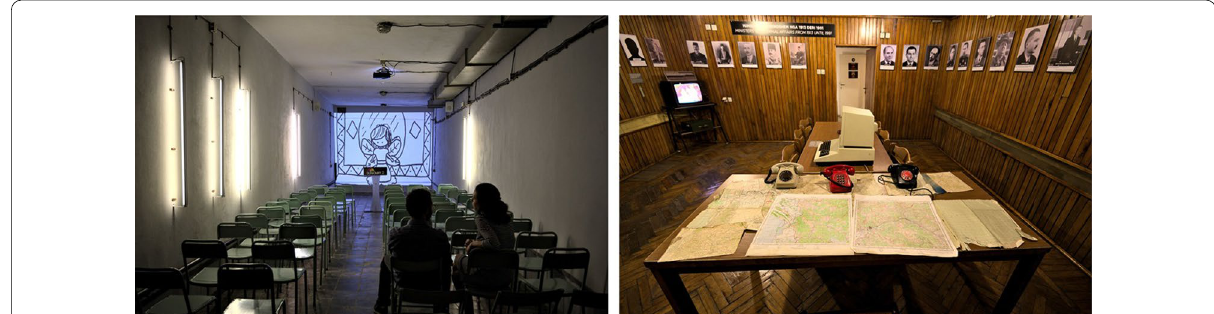
Fig. 11 Photos from the interior of the museum Bunkart 2, curated by Carlo Bollino